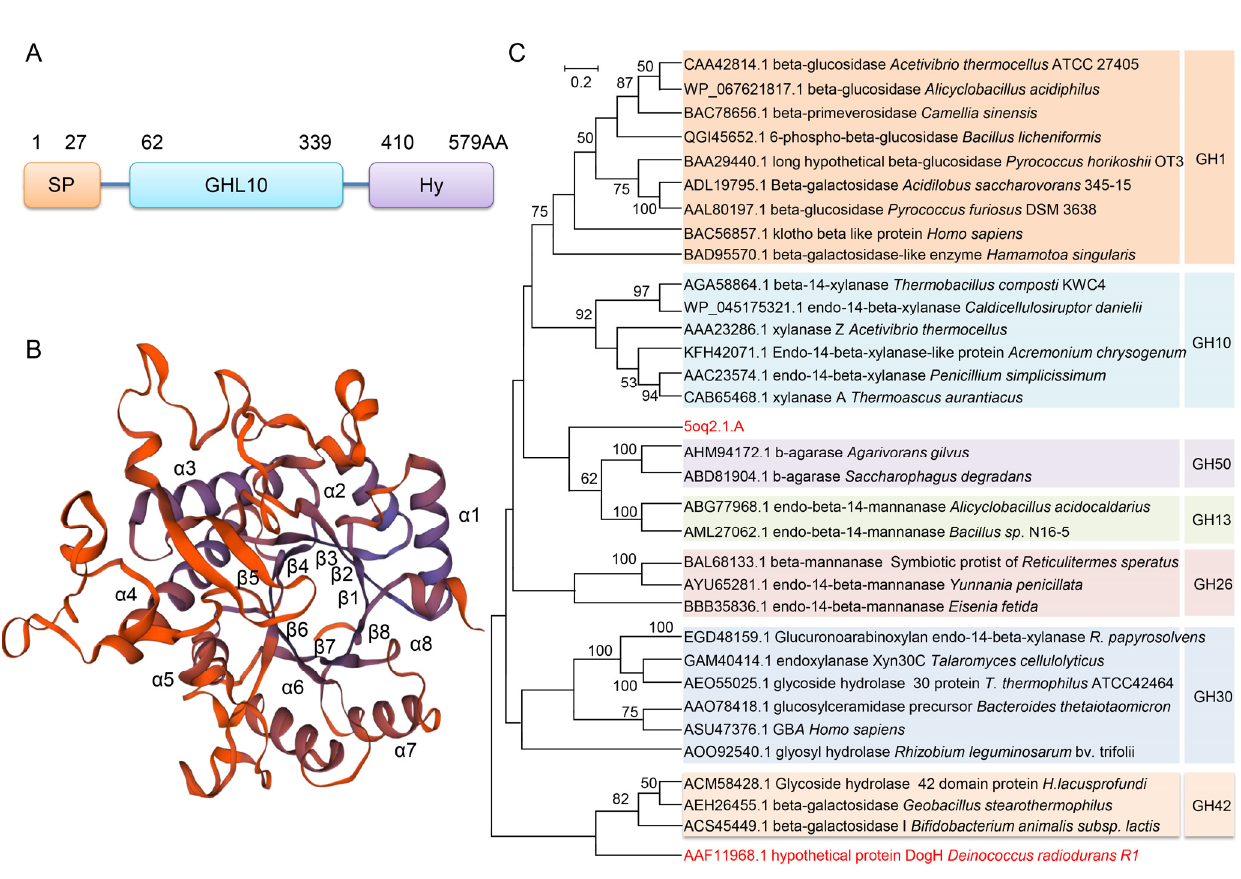
Figure 1. Domain architecture and phylogenetic analysis of the GHL10 domain of DogH. ( A ) Domain architecture of DogH drawn to scale. The full-length enzyme contains a predicted signal peptide (SP;residues 1 to 27), followed by a putative GHL10 domain (GHL10; residues 62 to 339) and hydrophilic end sequences (Hy;residues 410 to 579). ( B ) Ribbon diagram of the overall fold. DogH assumes a TIM barrel fold, forming an eight-stranded b-barrel surrounded by eight a-helices. The active site is formed over the center of the barrel, near the C-termini of b-strands. ( C ) Phylogenetic analysis of GH10 and other enzymes from families GH1, − 10, − 13, − 26, − 30, − 42, and − 50 in the GH-A clan. The tree was constructed using the maximum-likelihood method inferred by neighbor joining using 352 amino acid residues. Values above 50% are shown. Cwp19 crystal structure as a template (SMTL ID:5oq2.1.A) indicates the homologs of DogH characterized in this study.